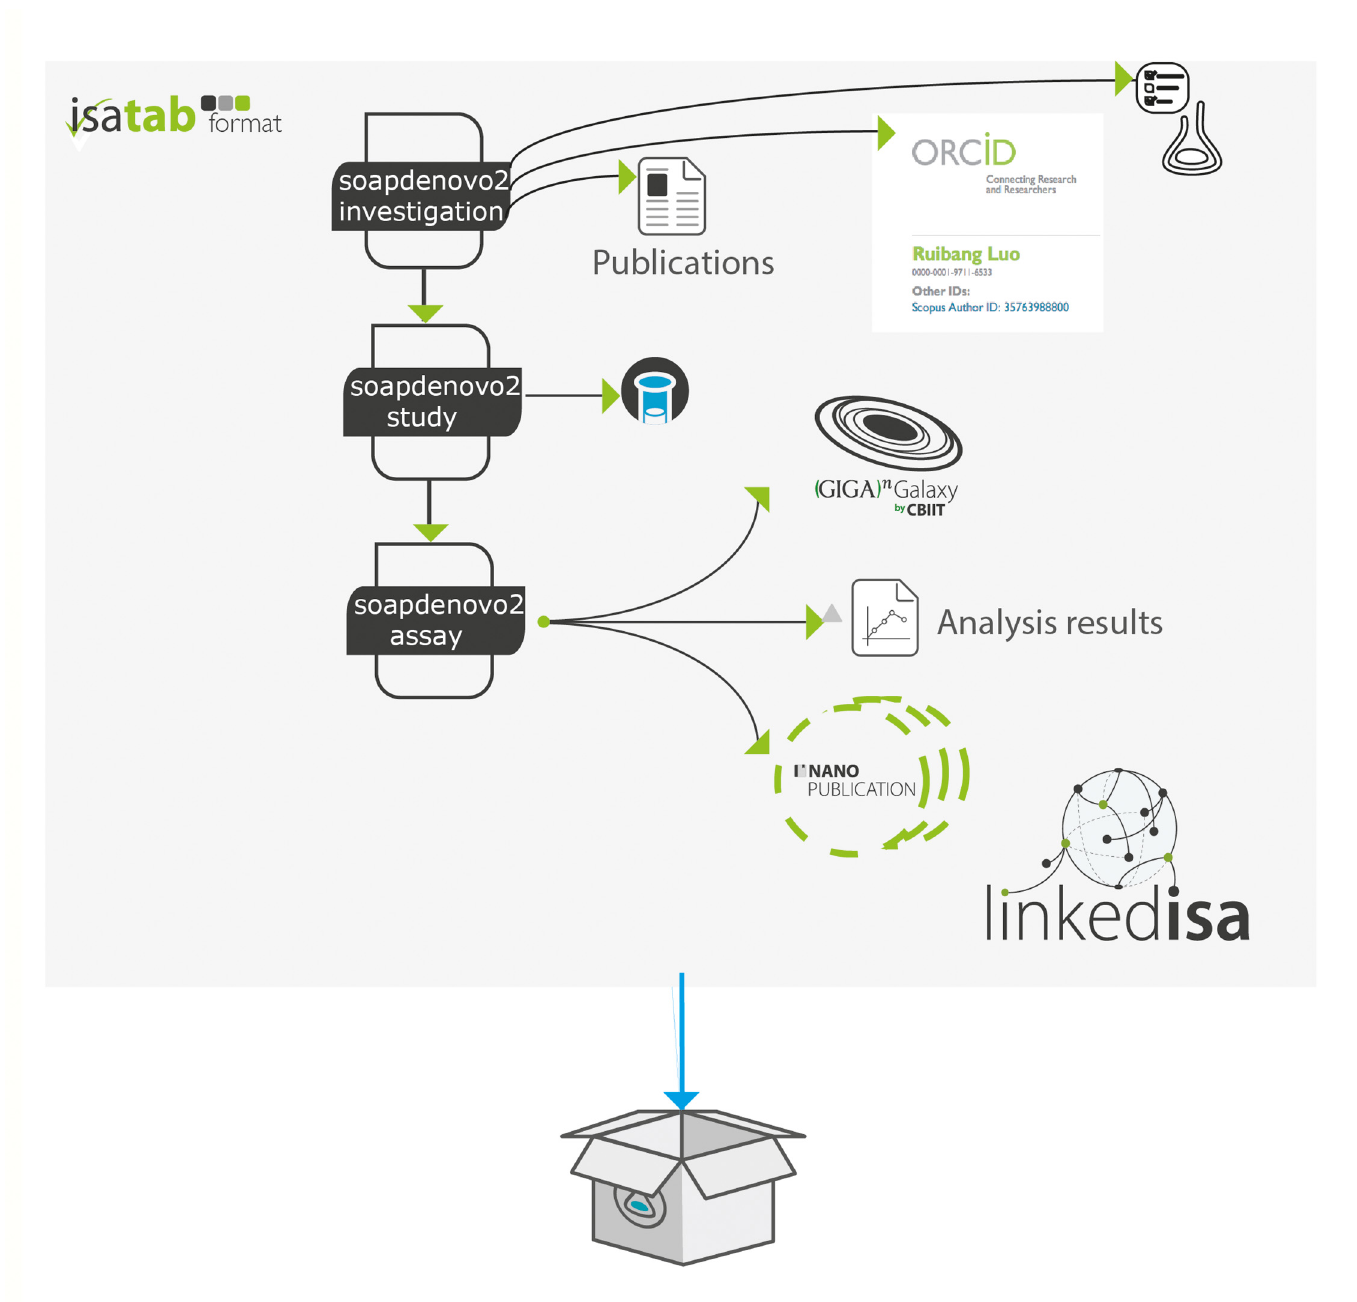
Fig 2. Another view of the complementary aspects of these research object models, highlighting the reliance of persistent identifiers (such as ORCID), and references to Galaxy workflows hosted on GigaScience Servers.